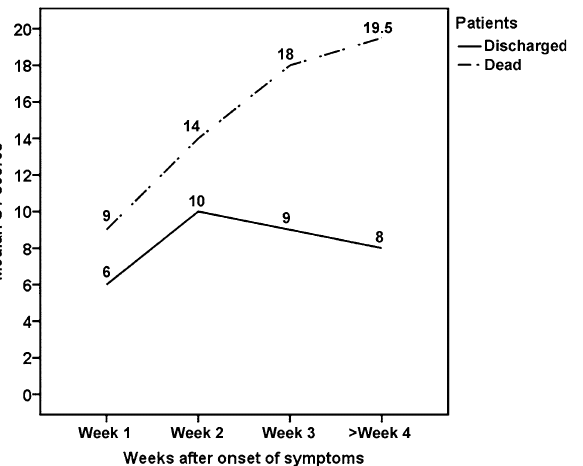
Figure 1. Line graph shows median CT scores in discharged and dead patients on CT scans at different time points after onset of symptoms.